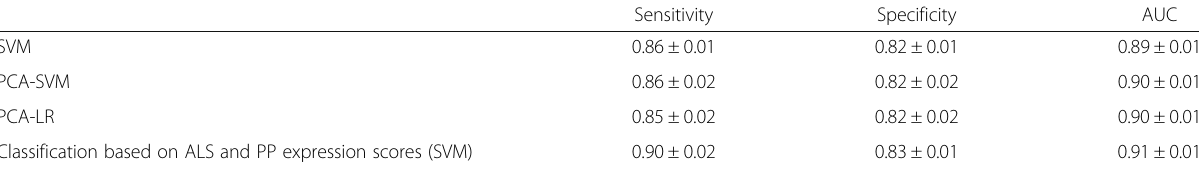
Table 1 Performance measures for classification between ALS and PP for SVM, PCA-SVM, and PCA-LR: sensitivity, specificity, and AUC. In addition, the accuracy measures are also given for a SVM classification between ALS and PP based on the ALS- and PP-specific pattern expression scores as determined by PCA-SVM by using a healthy control group and projecting individual 18 F-FDG PET scans onto the ALS and PP-specific metabolic brain patterns